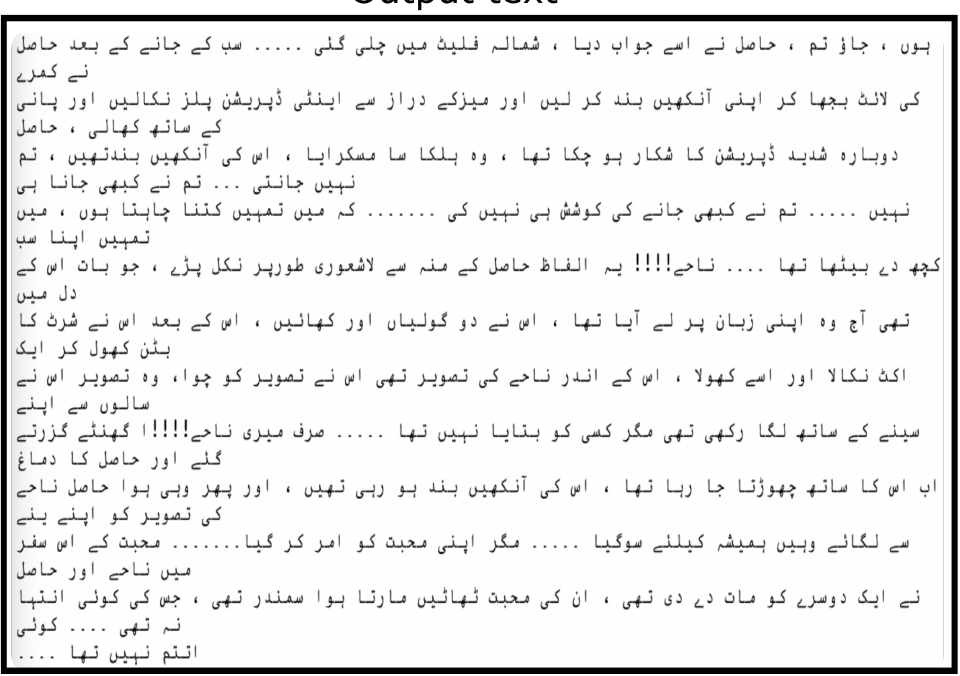
Figure 7. Text detection and recognition from an input image into an output text.